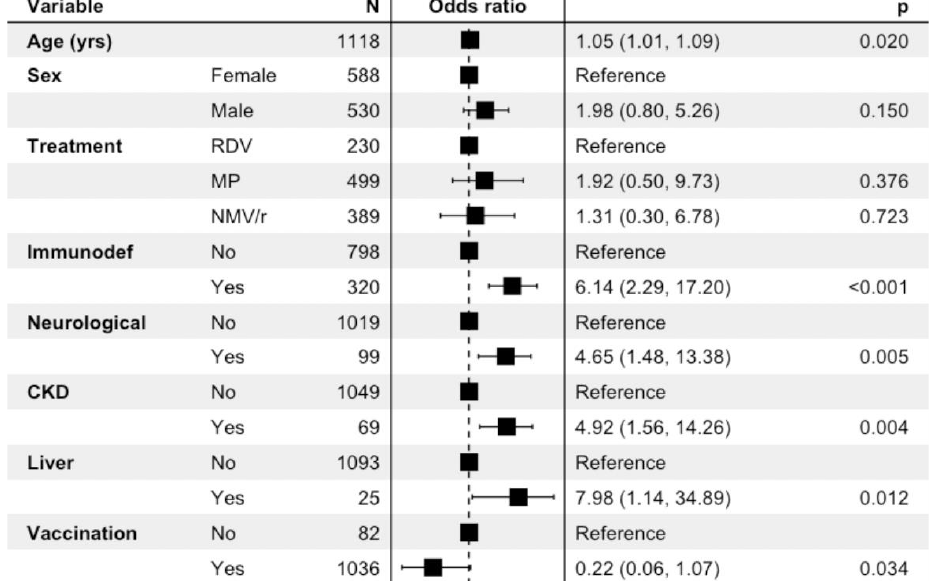
Figure 2. Logistic regression multivariate analysis of composite outcome (pneumonia, ARDS, COVID-19 Death, Non-COVID-19 Death) YRS: years; RDV: remdesivir; MP: molnupiravir; NMV/r: nirmatrelvir/ritonavir; CKD: chronic kidney disease.